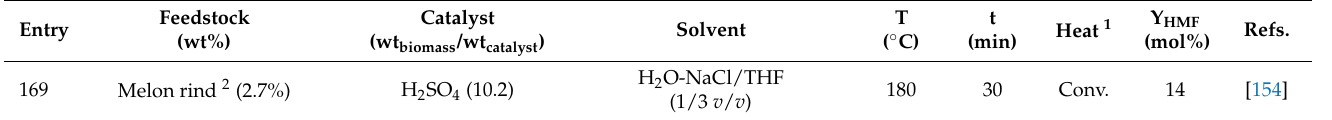
Table 9. HMF production from raw pretreated biomasses in biphasic and/or multiple-solvent systems with homogeneous catalysts (mineral acids, inorganic salts, and a combination of